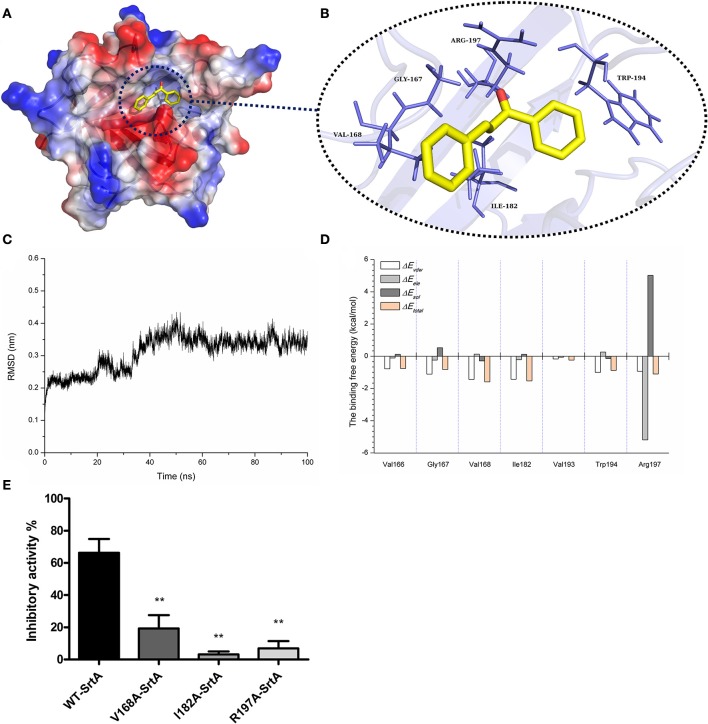
The 3D structural determination of a SrtA with chalcone complex by a molecular modeling method and the inhibitory effects of chalcone against WT-SrtA and SrtA mutants. (A) The structure of SrtA-chalcone. (B) The interaction of chalcone with the key residues of SrtA. (C) The RMSD displayed by the backbone atoms of the protein during MD simulations of SrtA-Chalcone is presented. (D) Decomposition of the binding energy on a per-residue basis at the binding sites of the SrtA-chalcone complex. (E) WT-SrtA and SrtA mutants (V168A-SrtA, I182A-SrtA and R197A-SrtA) were incubated with 76 μM chalcone, and the catalytic activity of the recombinant SrtA was determined as described in Figure 1A. **P < 0.01 vs. the WT group.